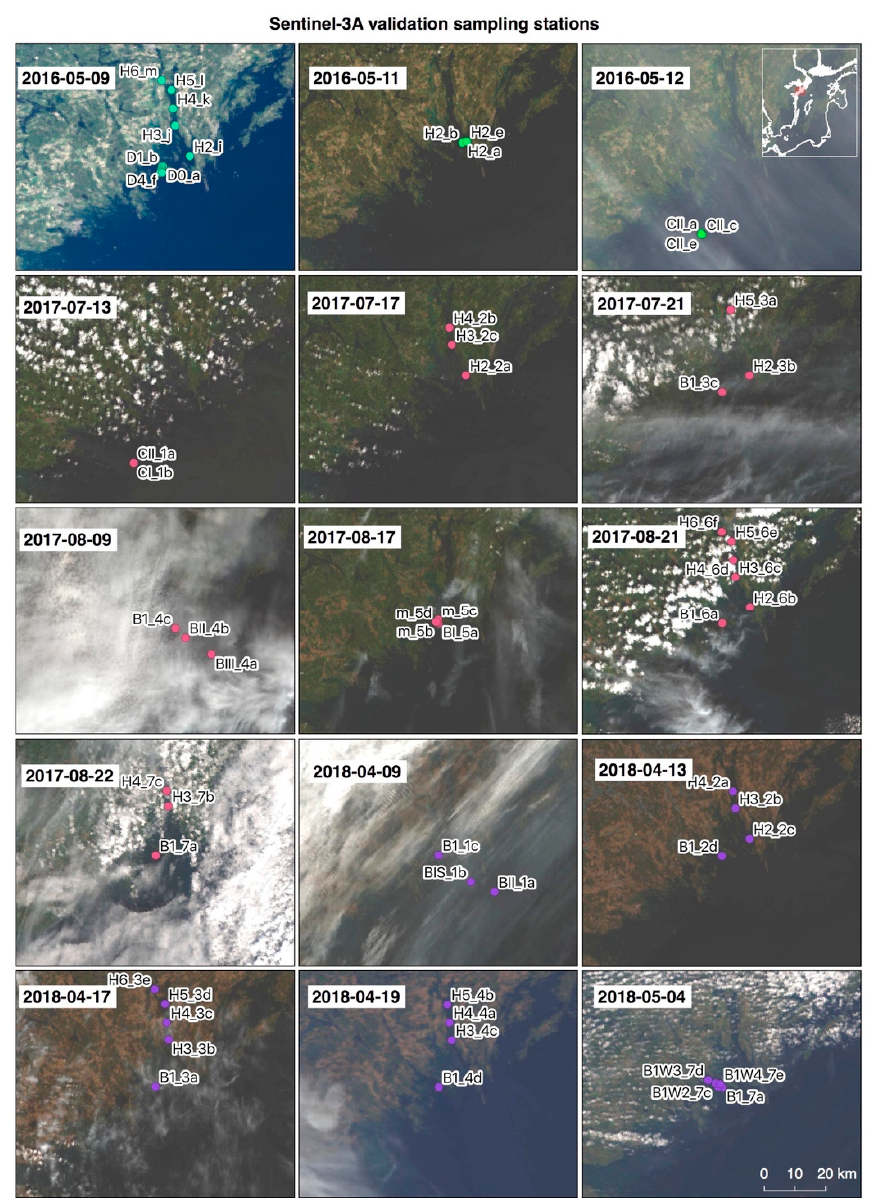
Figure 3. Overview of sampling stations during dedicated Sentinel-3A OLCI validation campaigns in the Baltic proper during May 2016, July–August 2017 and April–May 2018 super-imposed on full resolution True Color satellite images of the stations sampled in Baltic Sea coastal waters. The main challenge associated with validation efforts in the Baltic Sea is the extensive cloud cover as can be seen here on several satellite images. About 50% of the match-up stations were flagged.